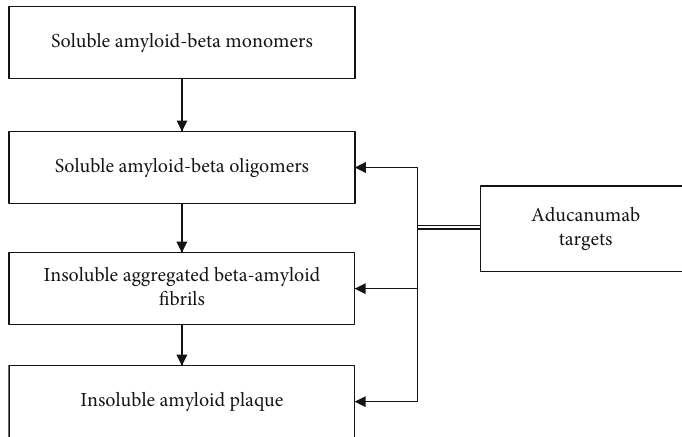
Figure 1: Schematic representation of aducanumab targets (soluble and insoluble beta-amyloid peptides); source